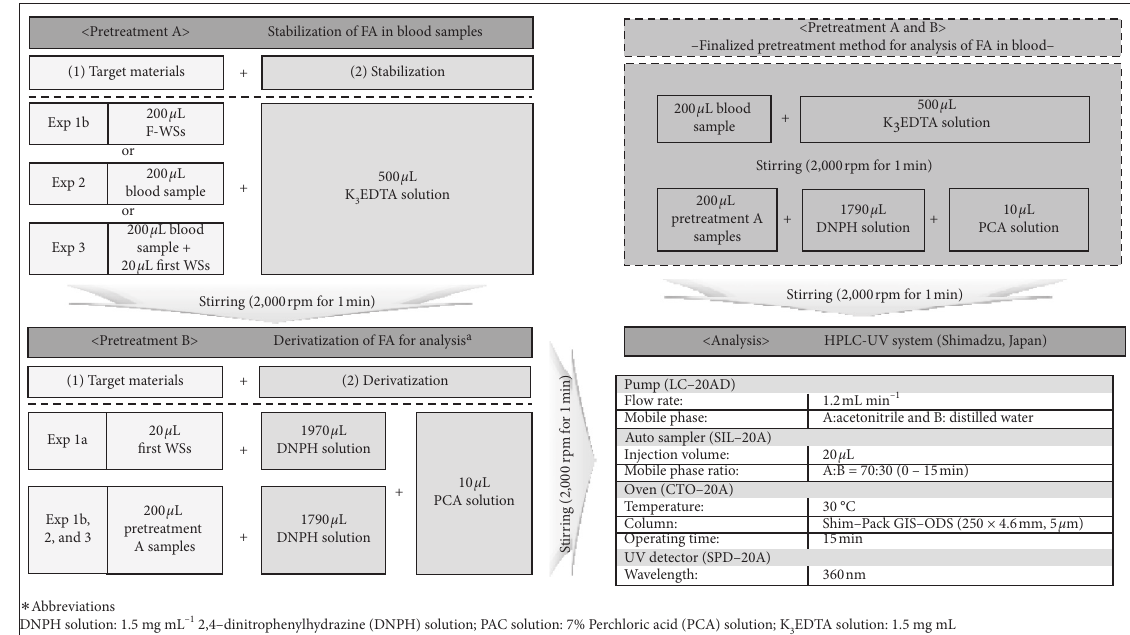
Figure 1: Schematic diagram of the standardized analytical method for the quantitative analysis of FA in